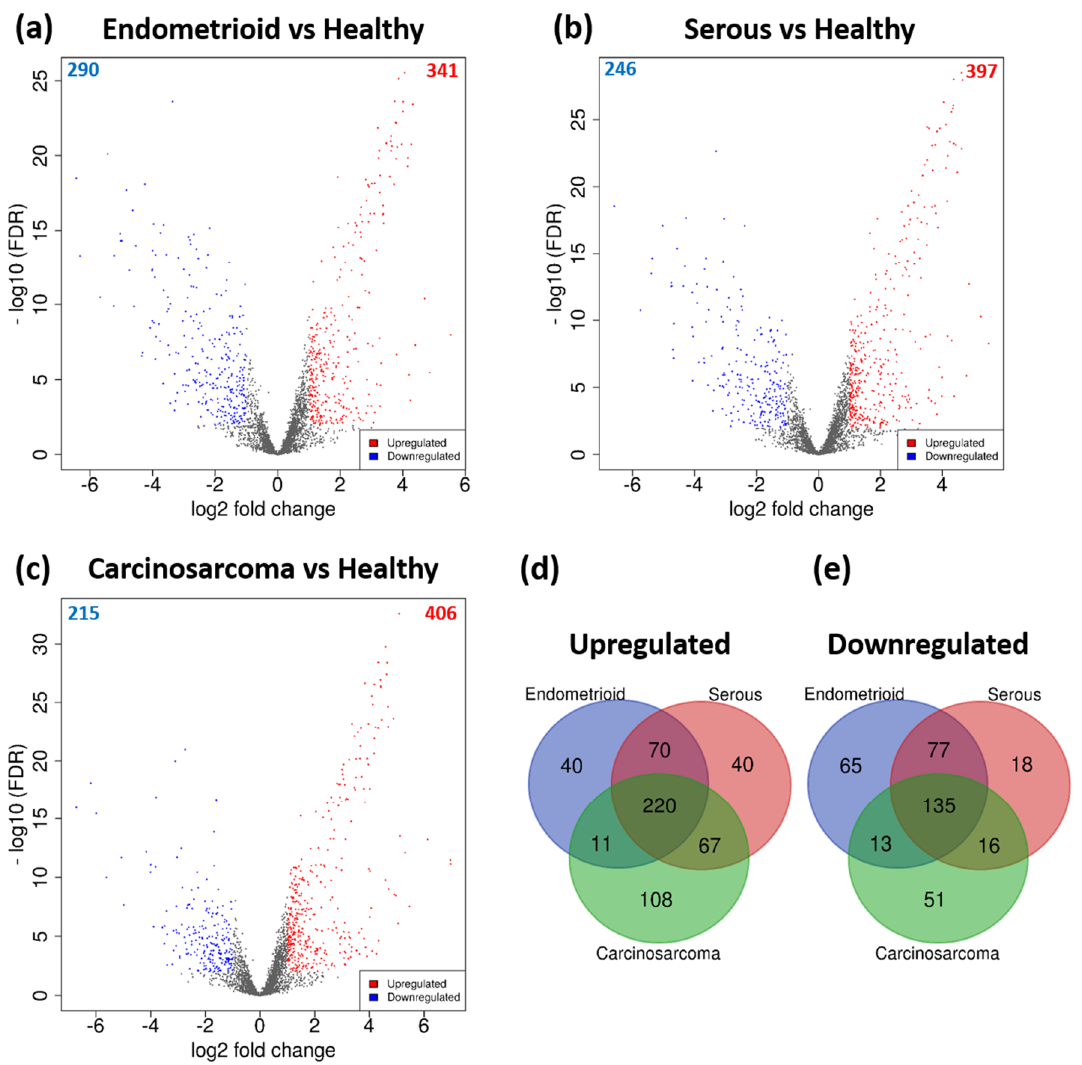
Figure 4. Volcano plots of DEGs between ( a ) endometrioid and healthy endometrium, ( b ) serous and healthy, and ( c ) carcinosarcoma and healthy. Significant DEGs are coloured; red dots represent upregulated genes, and blue dots represent downregulated genes. Cut-off criteria: │ log2FC > 1 │ and FDR < 0.01. Venn diagrams displaying common ( d ) upregulated and ( e ) downregulated genes between each subtype.